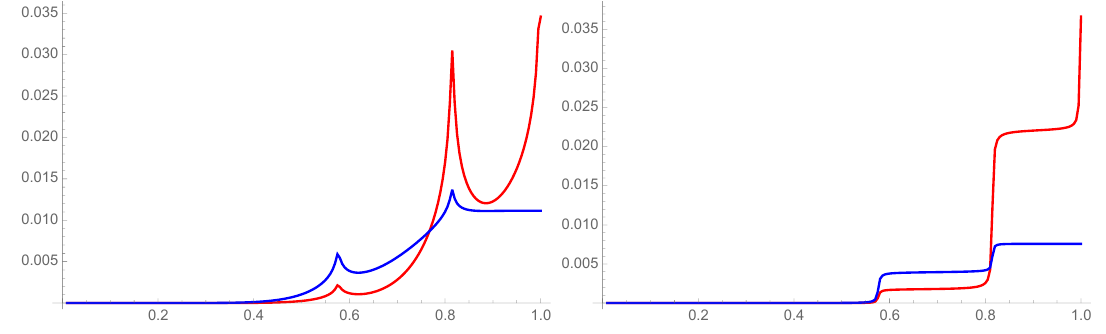
0 of the amplitude as a function 0 s is 12.05, near a pole. Contribution from 0